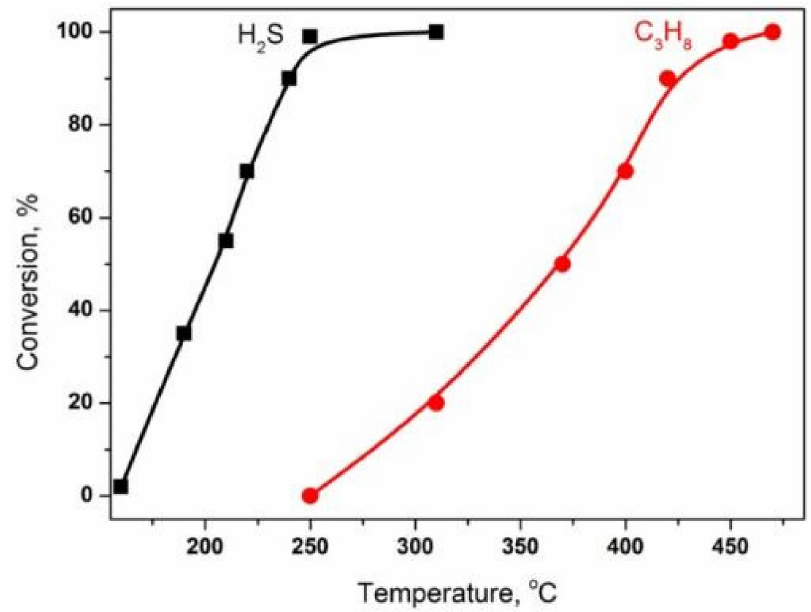
Figure 9. Results of laboratory experiments on the separate oxidation of propane and hydrogen sulfide over a MgCr 2 O 4 / γ -Al 2 O 3 catalyst (Catalyst: MgCr 2 O 4 / γ -Al 2 O 3 ; residence time: 0.8 s; C H2S : 30 vol.%; C C3H8 : 15 vol.%).